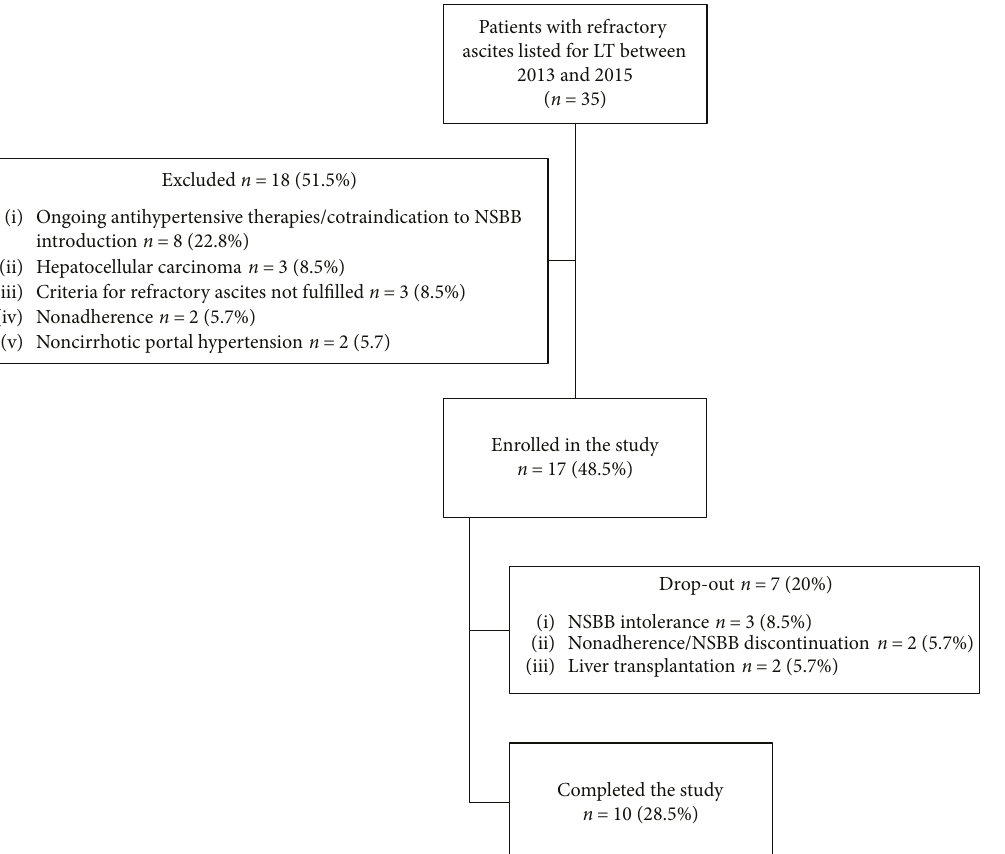
Figure 1: Patients ’ selection criteria and study design. NSBB: nonselective β -blockers. LT: liver